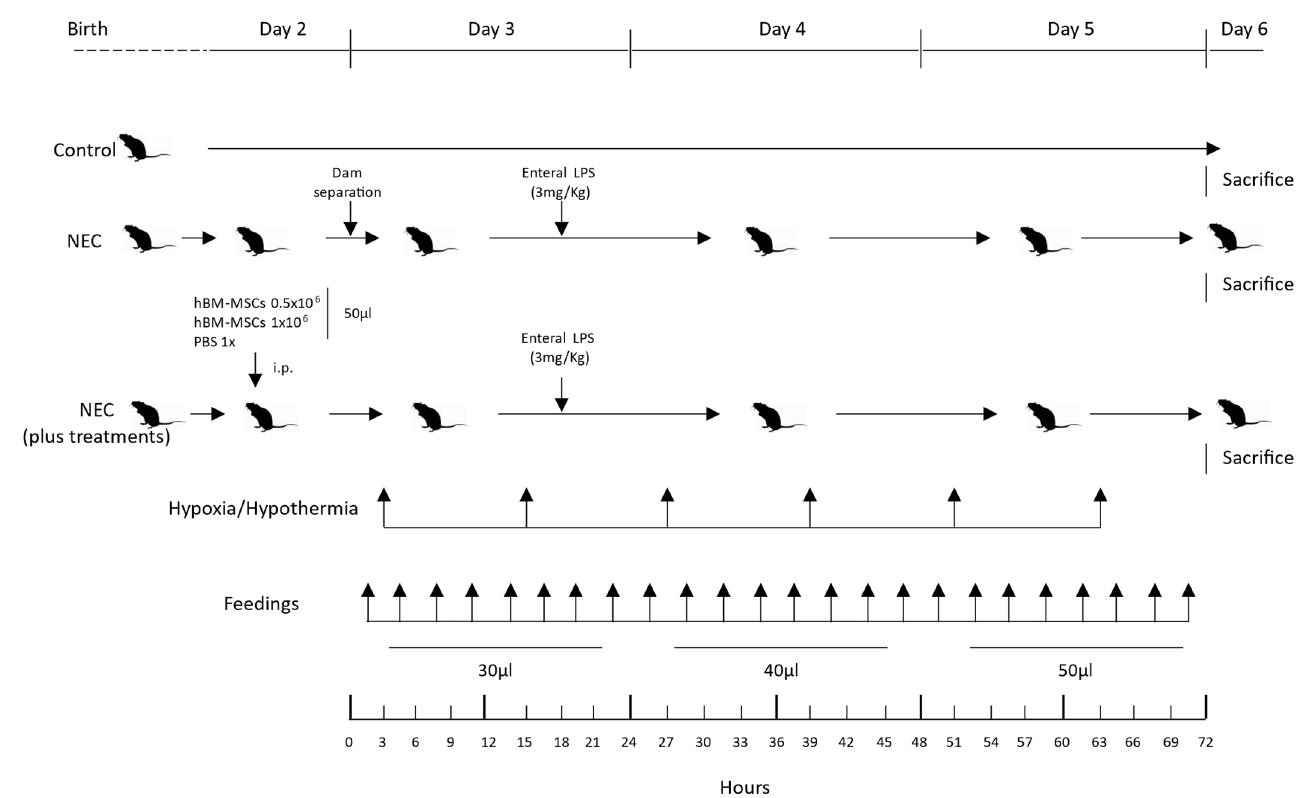
Figure 1. Timeline of NEC induction protocol. NEC, necrotizing enterocolitis; PBS, phosphate- buffered saline; hBM-MSCs, human bone marrow-derived mesenchymal stromal cells; LPS, lipopolysaccharide; i.p., intraperitoneal.